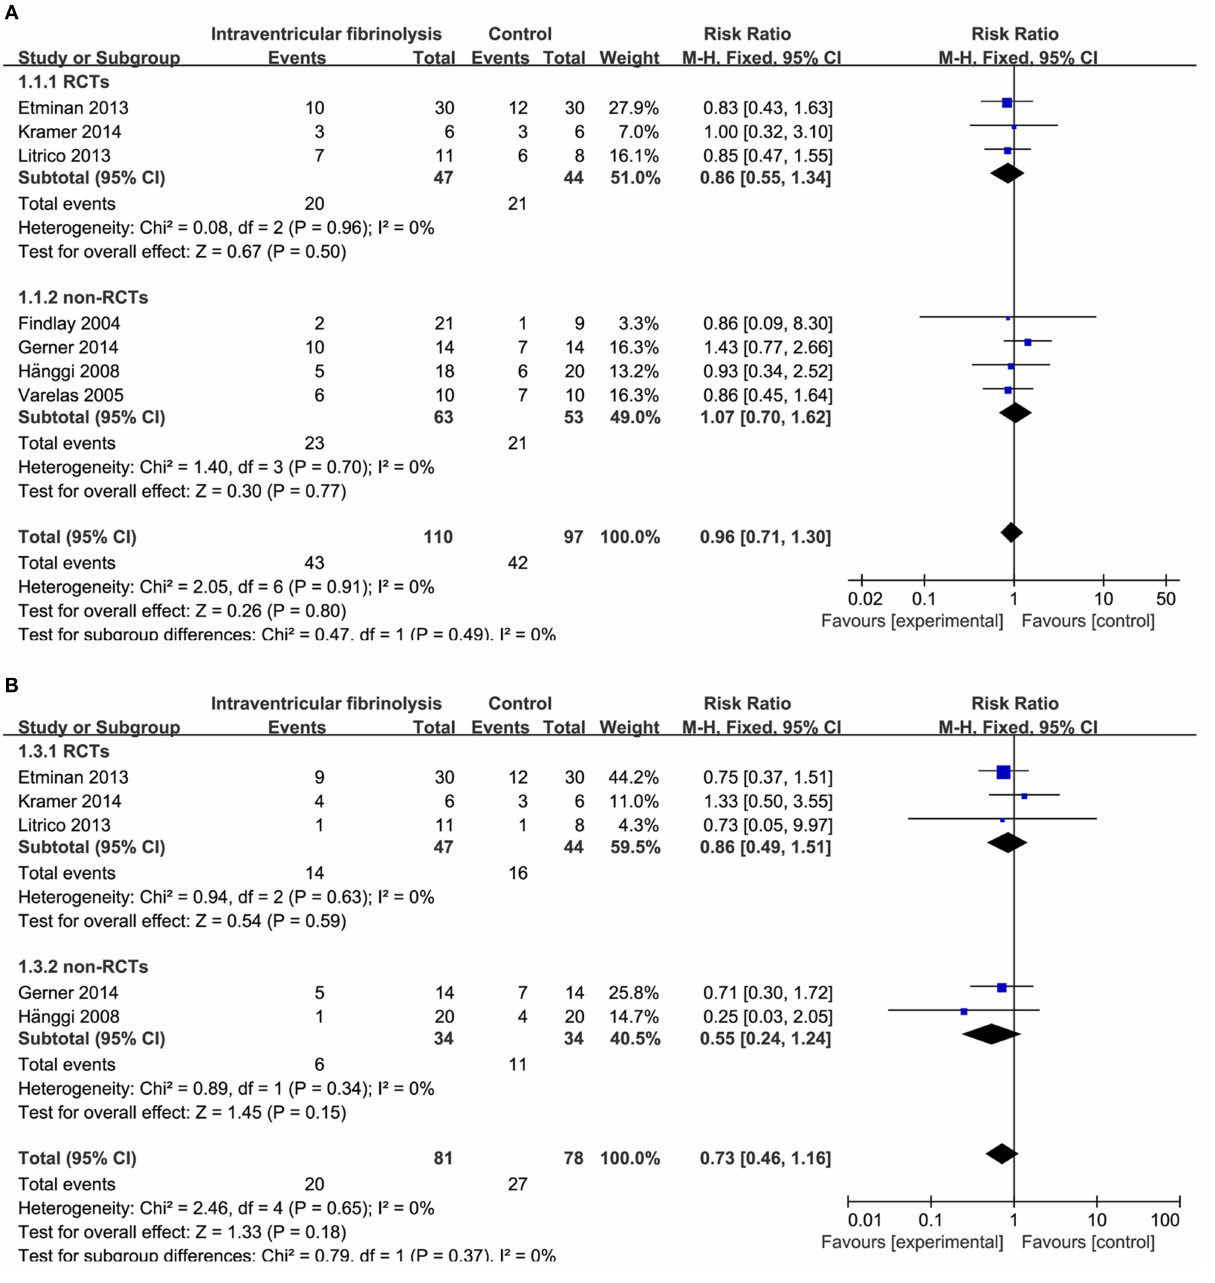
FIGURE 4 | Meta-analysis of associations between intraventricular fibrinolysis and the risk of poor neurologic recovery (A) or the risk of DIND (B) in aSAH patients. aSAH, aneurysmal subarachnoid hemorrhage; CI, confidence interval; DIND, delayed ischemic neurologic deficit; M–H, Mantel–Haenszel method; RCTs, randomized controlled